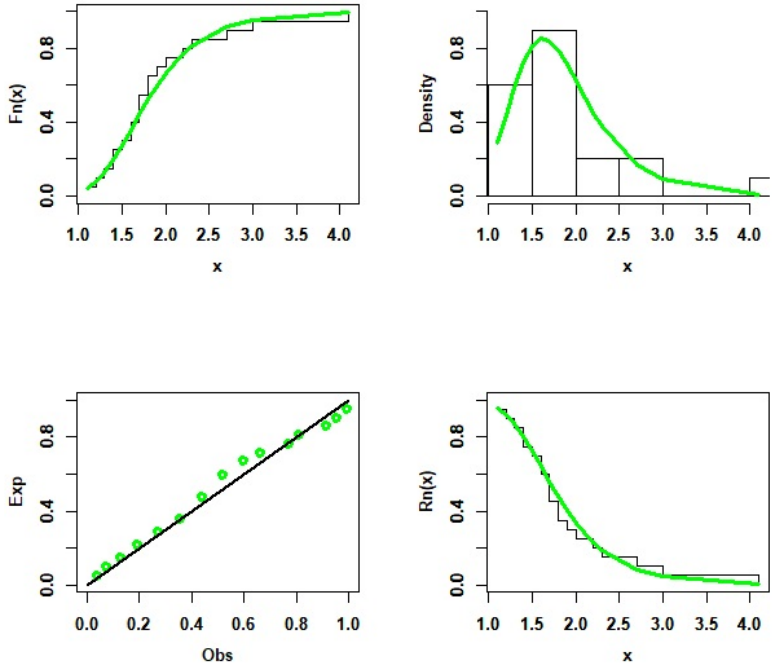
Figure 7. The fitted cdf, pdf, and pp plots and the estimated plot for the second